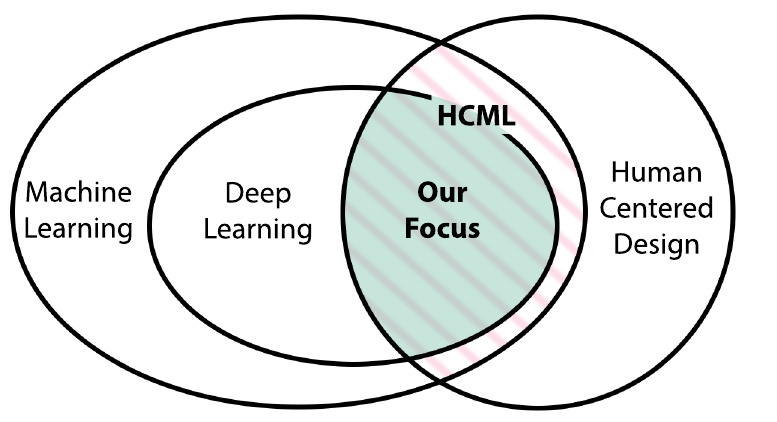
Figure 3. Human-Centered Machine Learning (HCML) is the intersection of Machine Learning and Human-Centered Design (marked with pink stripes). In this paper, our focus lies in HCML approaches related to Deep Learning as marked by the green